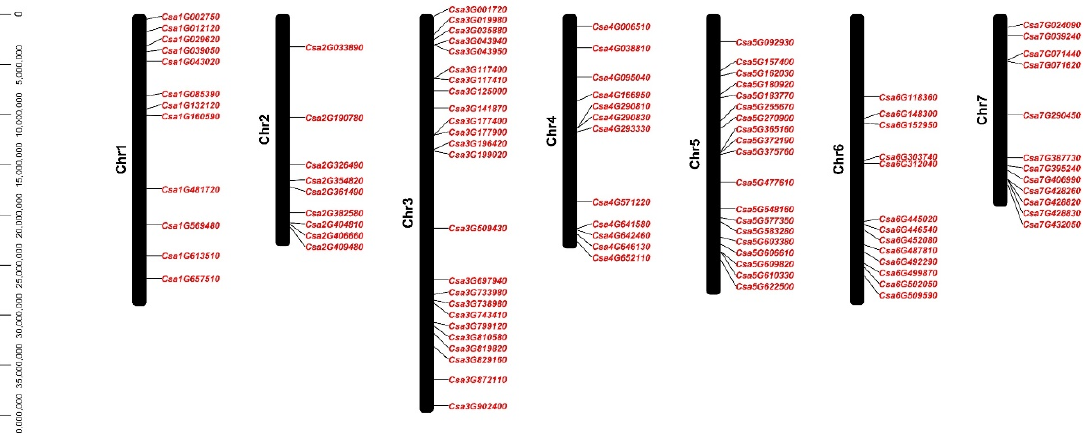
Figure 1. The gene locations of C2H2 zinc finger protein (C2H2-ZFP) genes in cucumber. The scale bar on the left represents the length of the chromosome (bp).